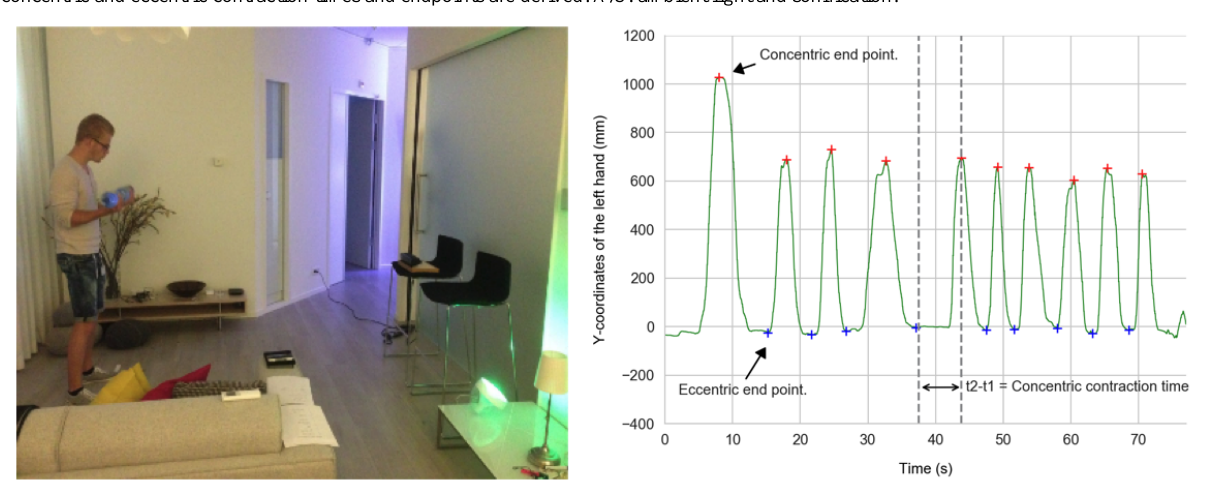
Figure 1. Left: example of the experimental setting while performing frontal shoulder raises showing the Kinect placement, the ambient lights (green light on the table, and a spot light on the roof, not visible), and the white panel behind which the coaching experimenter is sitting. In the verbal and A/S condition, the participant wears headphones to add the auditory feedback. Right: recording of the bicep curl with the Kinect in Max 7, showing how the concentric and eccentric contraction times and endpoints are derived. A/S: ambient light and